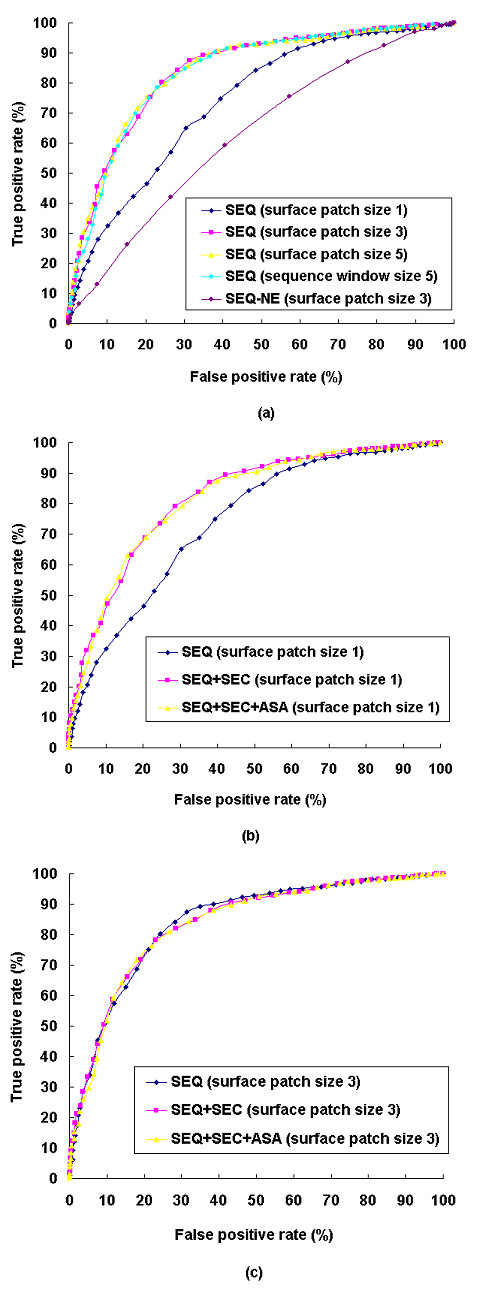
ROC curves for the prediction of interacting and non-interacting protein binding sites using different input features. (a) Predictions using only sequence profile/sequence information but different surface patch or sequence window sizes. Predictions using different combinations of sequence profile, secondary structure, and ASA when (b) surface patch size is 1 (c) surface patch size is 3. SEQ: sequence profile; SEQ-NE: sequence information only (without the evolutionary information provided by homologous sequences); SEC: secondary structure; ASA: accessible surface area.